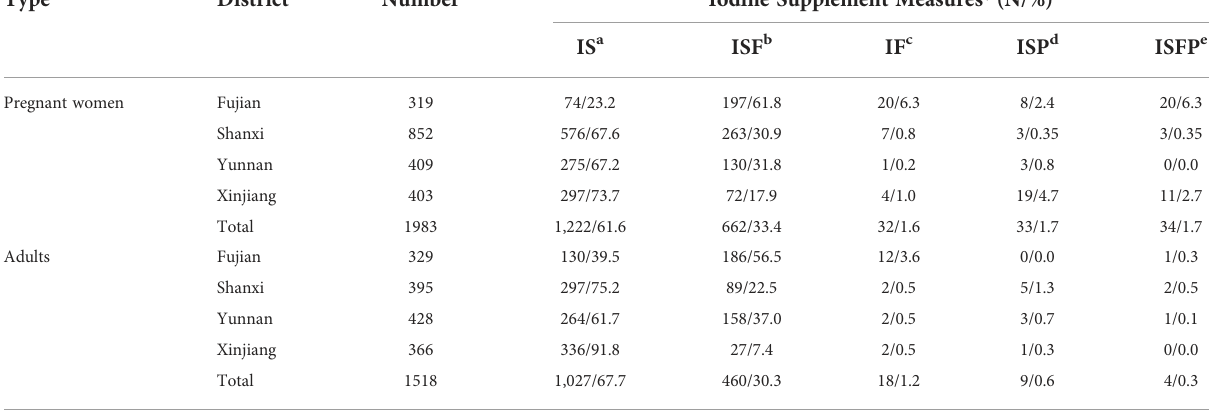
TABLE 3 The iodine supplement measure of adults and pregnant women.